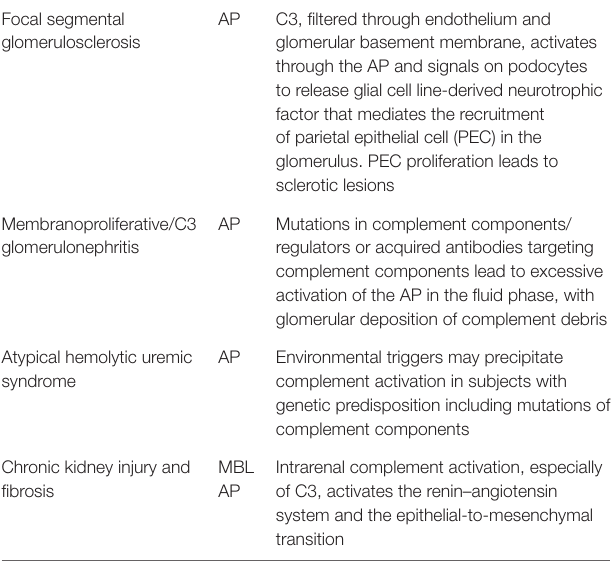
TAbLe 1 | Complement involvement in non-antibody renal